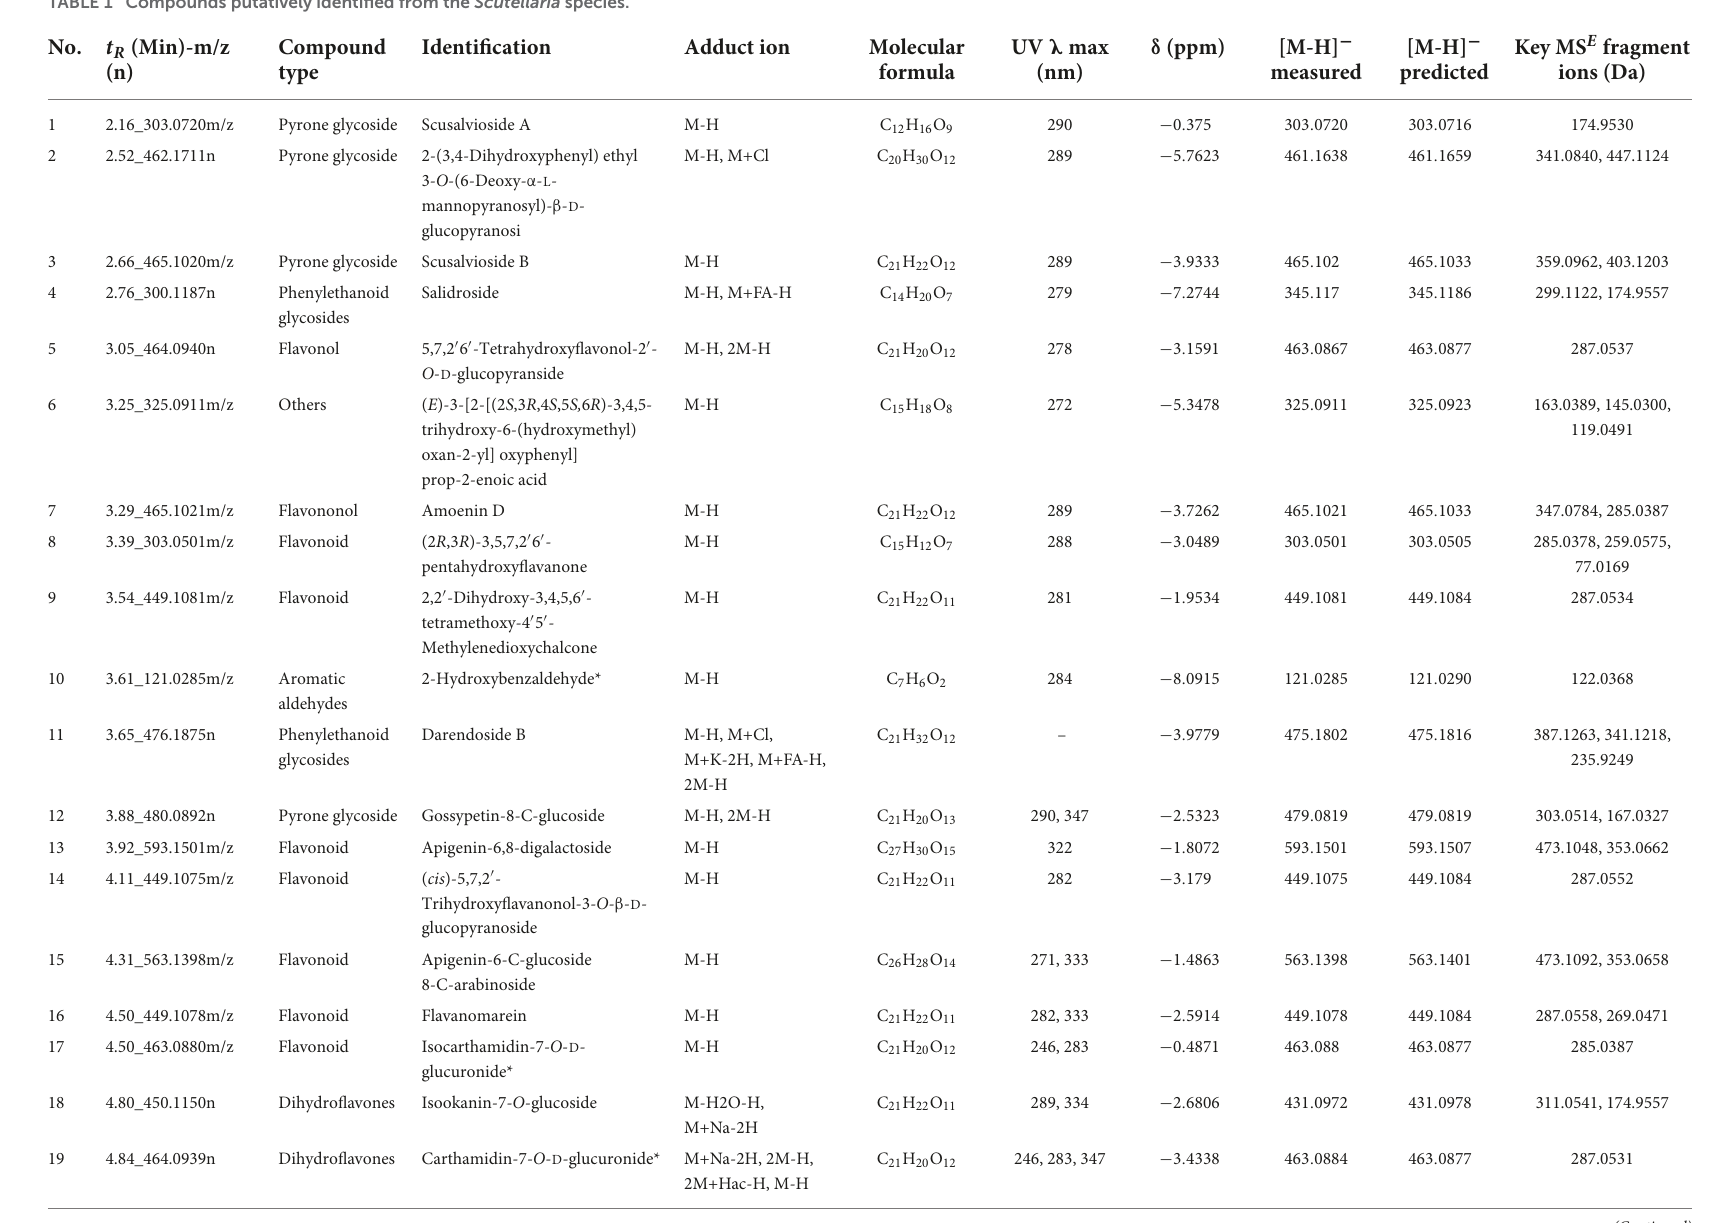
TABLE 1 Compounds putatively identified from the Scutellaria